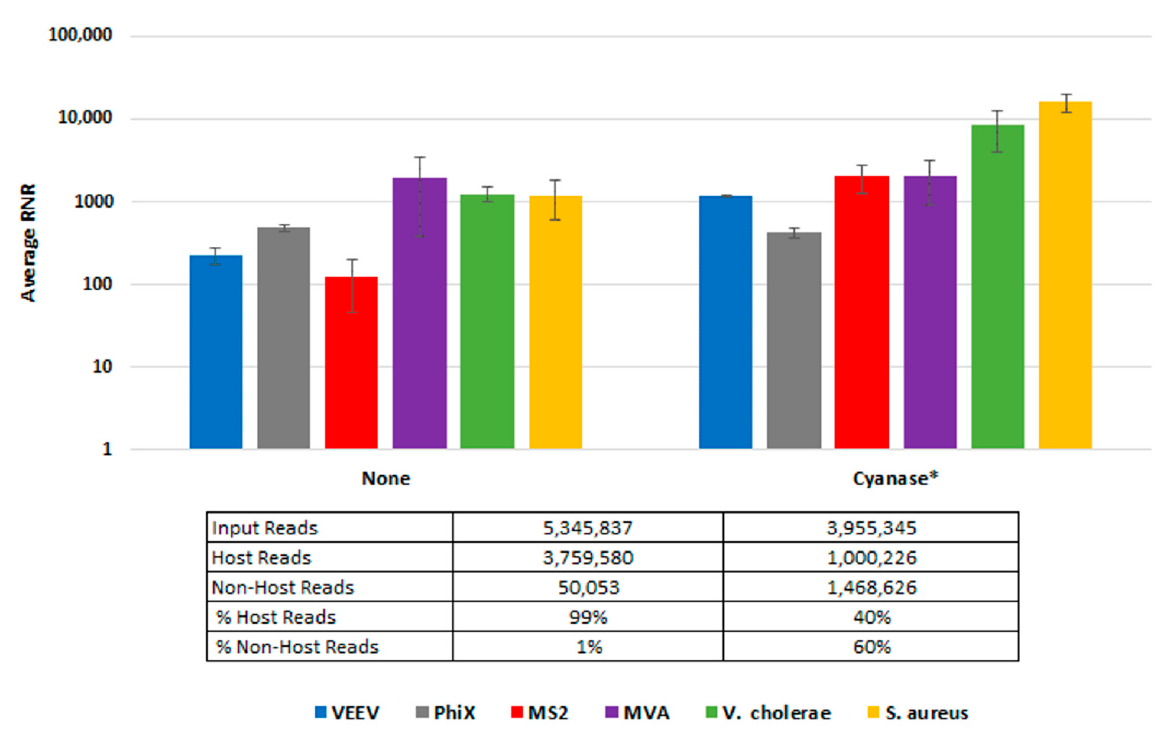
Figure 3. Cyanase Impact on Number of Reads. This figure compares average RNR values for fractionated blood samples treated with Cyanase and those without treatment. The final PanGIA Clinical Workflow was used to process these samples following extraction, with the sole difference limited to utilizing the Cyanase treatment or not. * Indicates only three samples included in the data set, instead of four (one sample was excluded due to a low number of input reads).